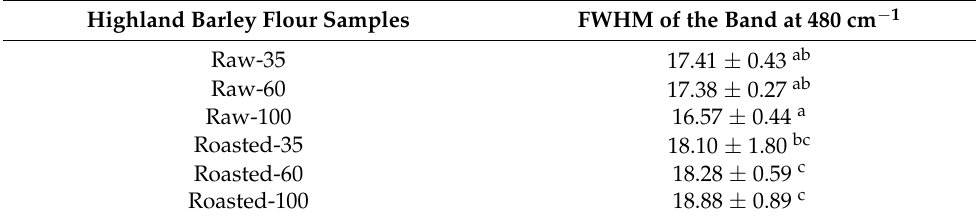
Table 2. Short-range molecular orders of starch in raw and sand-roasted highland barley flours. Highland Barley Flour